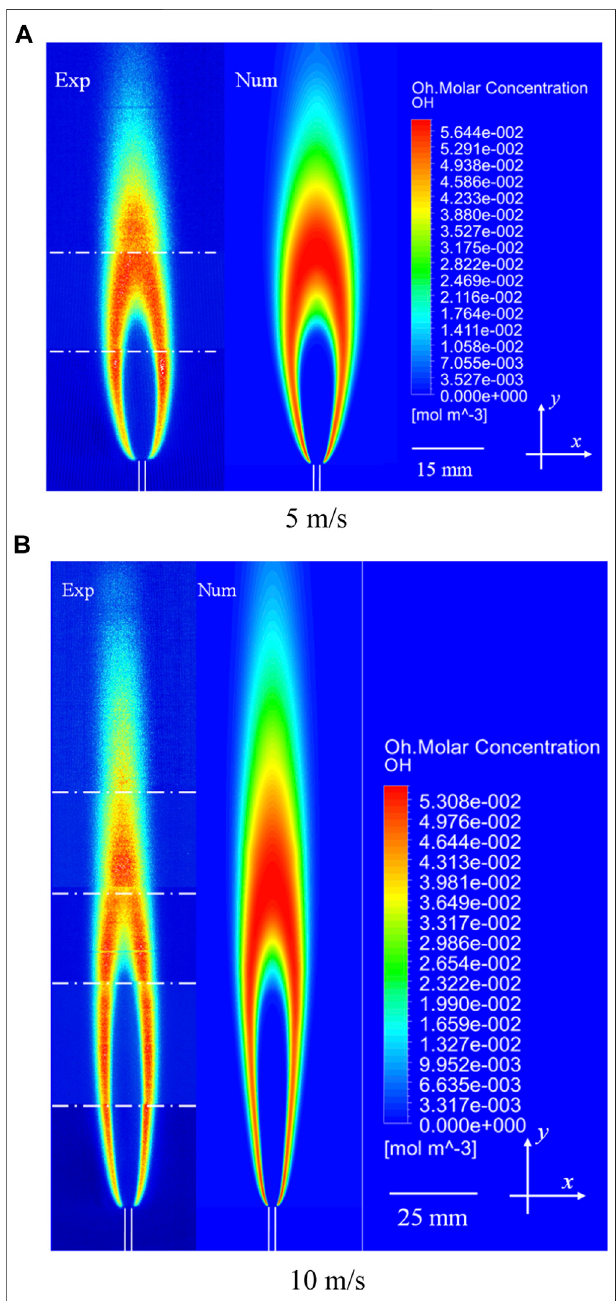
FIGURE6| Measured and computated OHdistributionsoflaminarnon- premixed CH 4 jet fl ames in an O 2 /CO 2 co fl ow at fuel jet velocities of 5 and 10 m/s. (A) 5 m/s. (B) 10